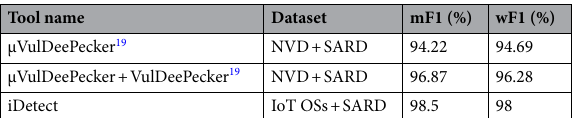
Table 4. The experimental results of multiclass classification between related work tools and iDetect.